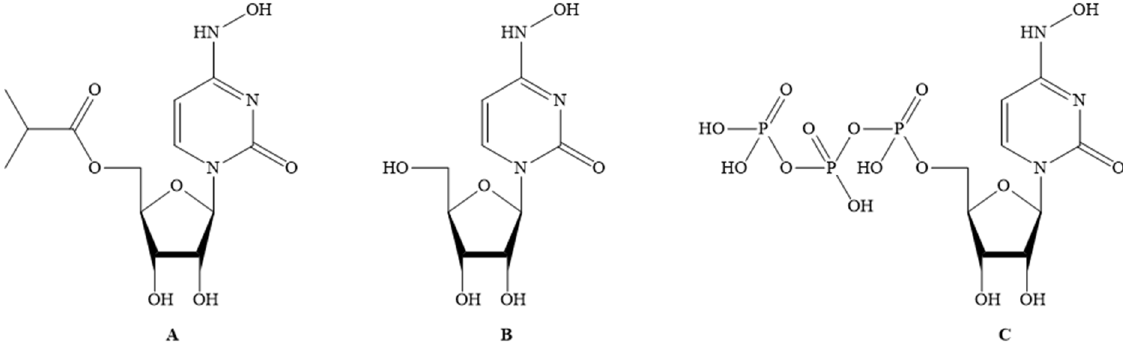
Figure 1. ( A ) Molnupiravir; ( B ) EIDD-1931; ( C ) EIDD-1931-triphopsphate.